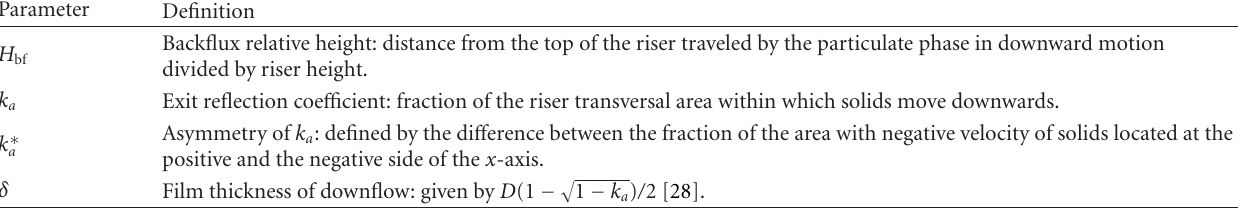
Table 9: Parameters applied to evaluate the influence of the exits on the flow.